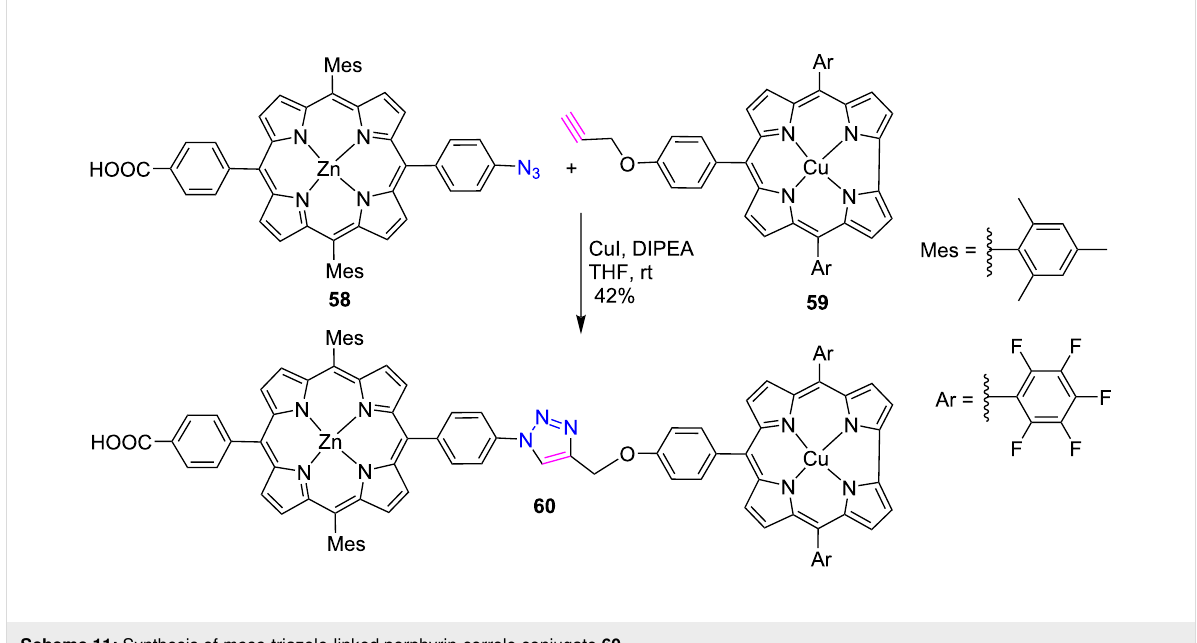
Scheme 11: Synthesis of meso -triazole-linked porphyrin-corrole conjugate 60 .